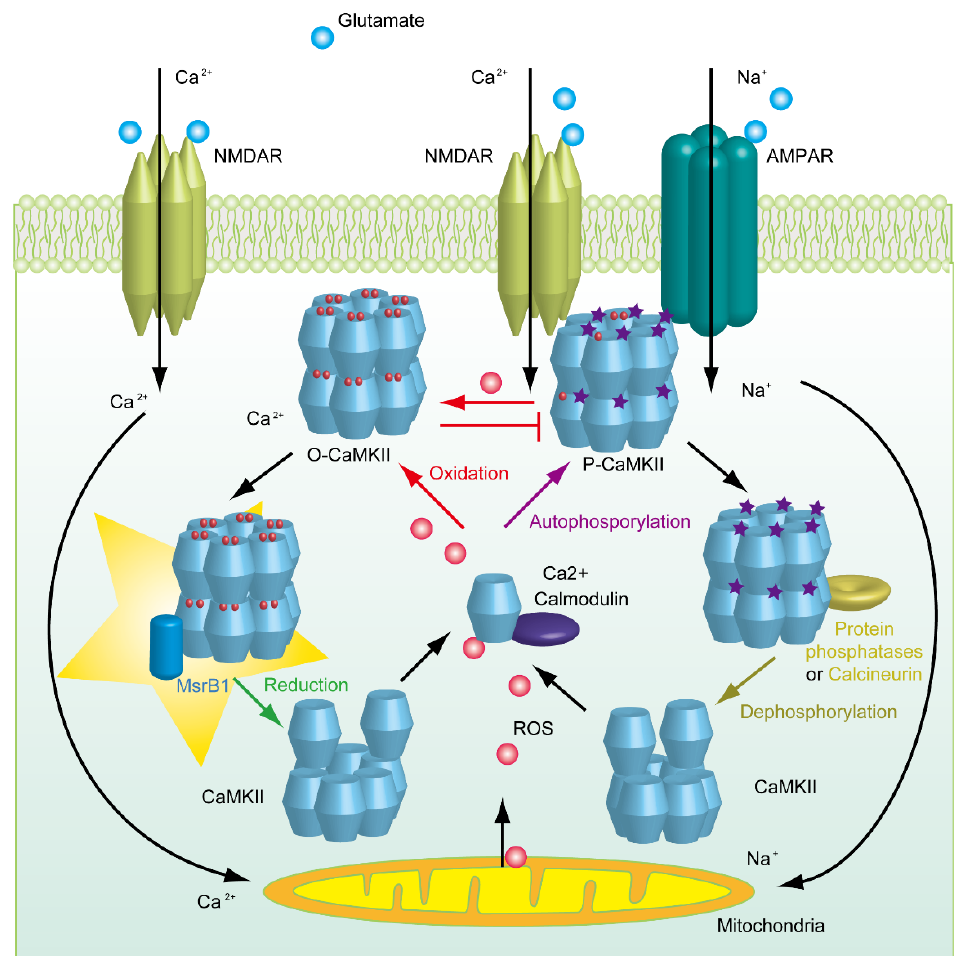
Figure 3. Schematic description of the hypothesis of how MsrB1 is involved in synaptic plasticity. The autophosphorylation of CaMKII could be triggered by Ca 2+ /calmodulin in an excited neuron. However, the overload of Ca 2+ could induce excitatory toxicity, including the production of ROS by mitochondria, which could further oxidize CaMKII and perturb the phosphorylation of CaMKII. Therefore, synaptic plasticity would be impaired by excessive ROS. Meanwhile, MsrB1 could reduce the oxidized methionine residue in CaMKII and subsequently rescue the synaptic plasticity.